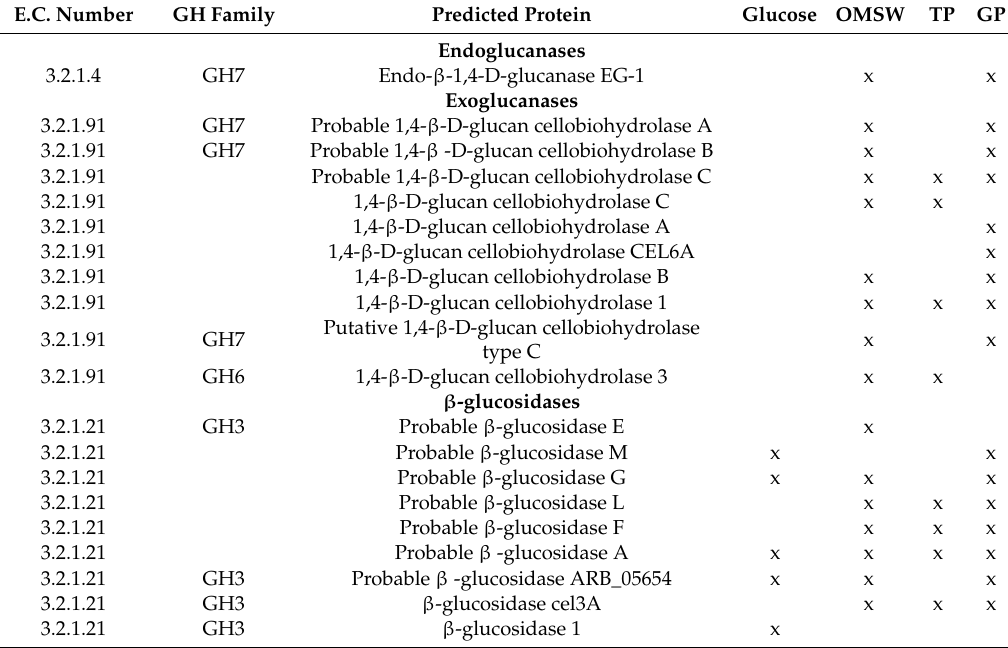
Table 1. Cellulases found in the culture supernatants of the Trichoderma sp. grown on Mandel medium supplemented with glucose or